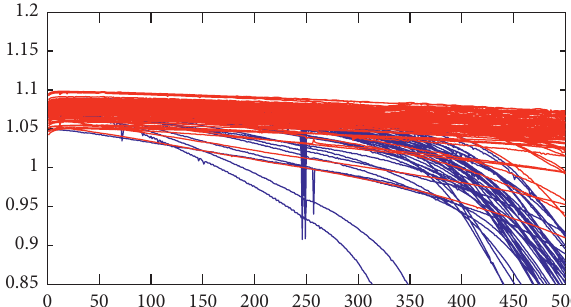
Figure 3: Capacities in different cycles. x -axis: cycle number and y - axis: capacity. Red lines: batteries with high lifetime. Blue lines: batteries with low